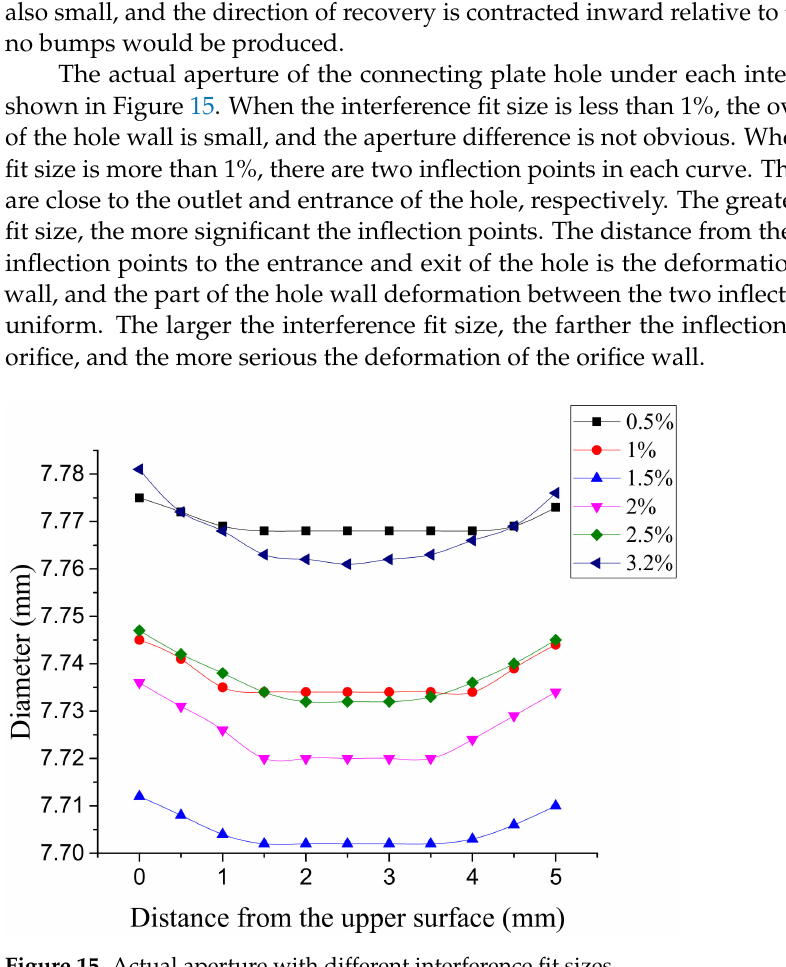
Figure 15. Actual aperture with different interference fit